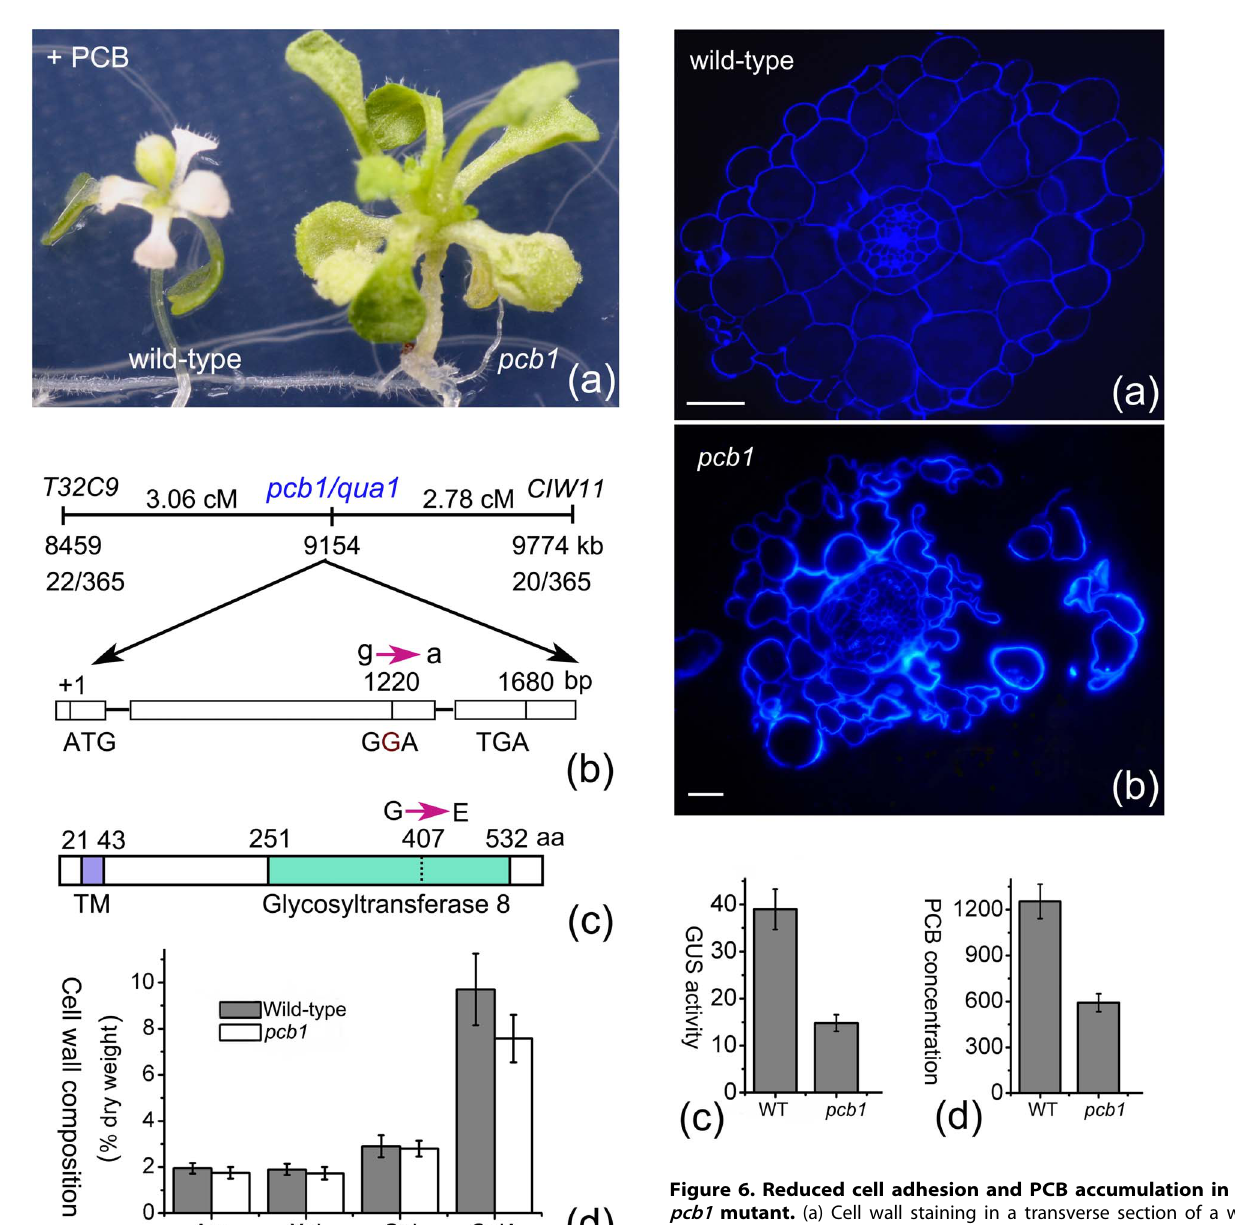
galacturonosyltransferase led to reduced pectin biosynthesis and PCB accumulation. Pectins are synthesized in the Golgi